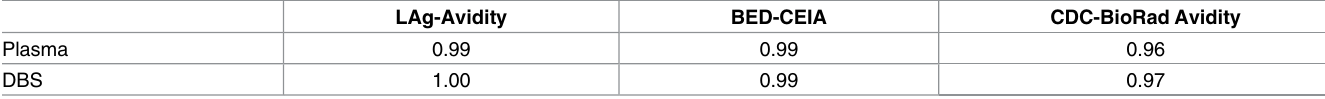
Table 2. R 2 values for replicate plasma and DBS samples tested with LAg-Avidity, BED-CEIA, and CDC-BioRad Avidity.